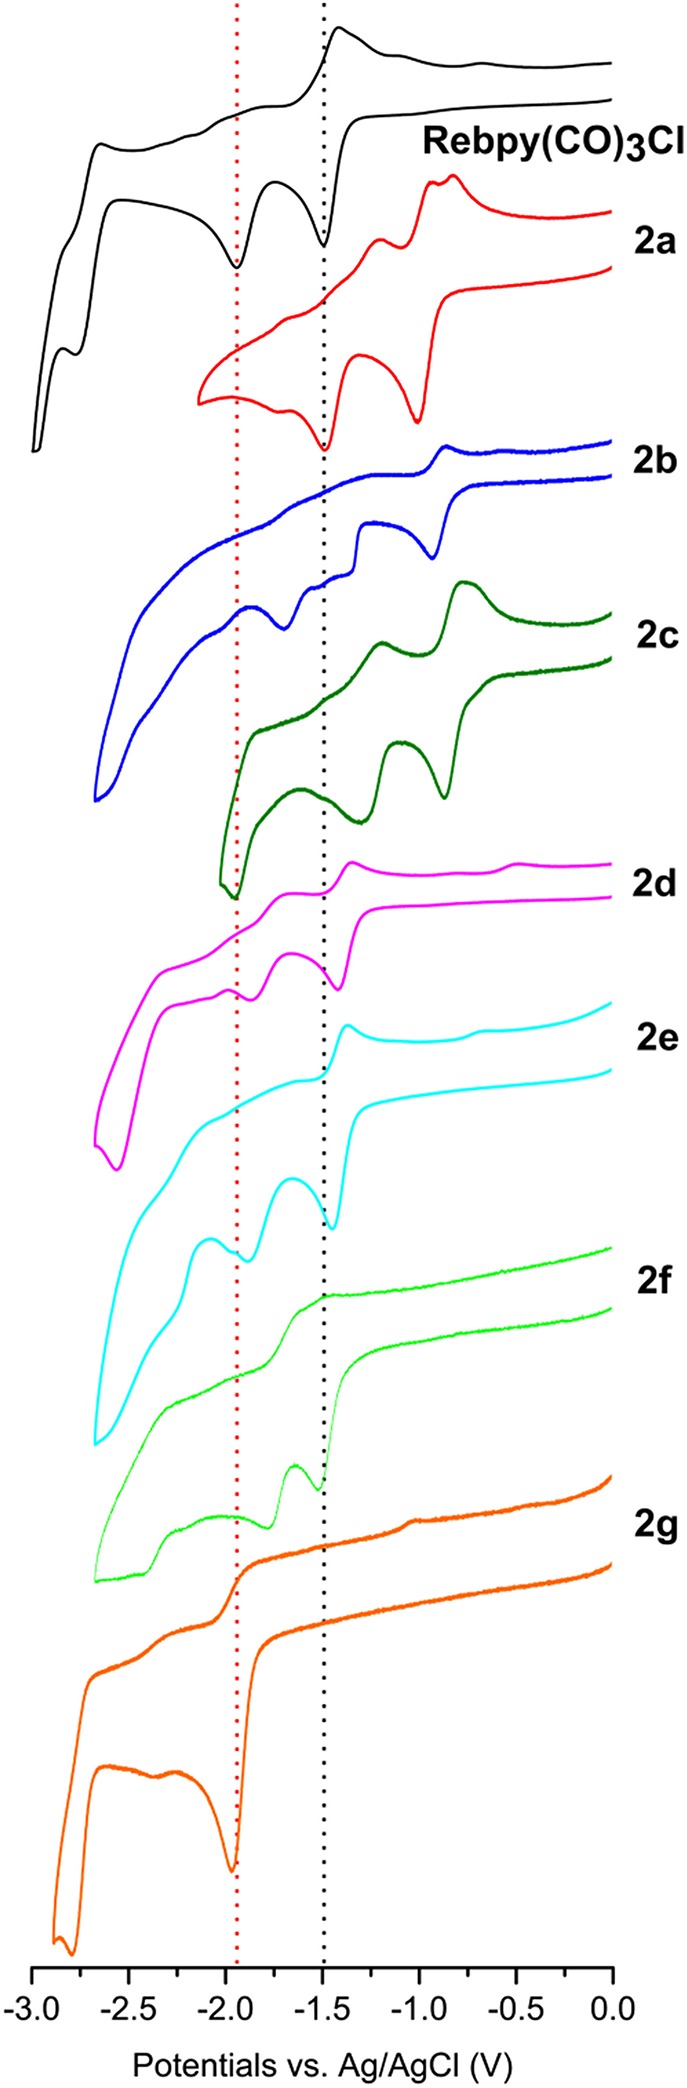
CVs of 1 mM solutions of 2a−2g Re complexes in MeCN/0.1 M TBAPF6 at GCE, scan rate 200 mVs−1 under Ar. CV of the reference fac-Re(bpy)(CO)3Cl is in black.